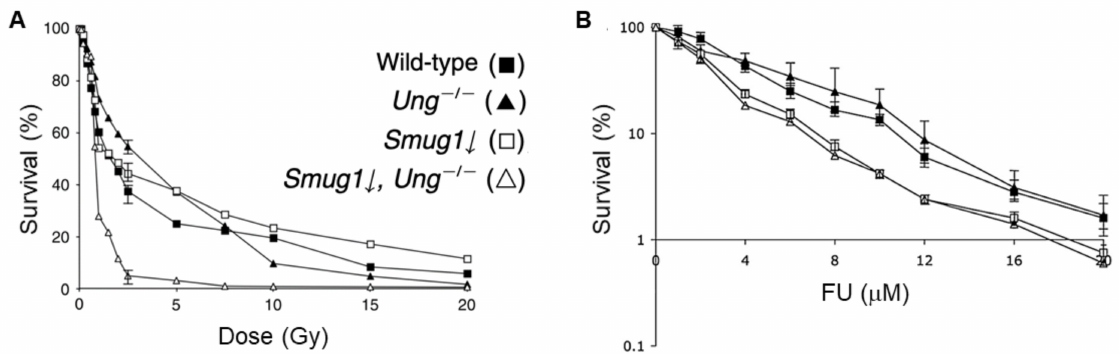
Figure 4. SMUG1 has a protective role after specific types of DNA damage. Survival of wildtype, Ung − / − , Smug1 knock- down and Smug1 knockdown and Ung − / − MEFs were analyzed after treatment with: ( A ) ionizing radiation, from [42] with permission, or ( B ) 5-fluorouracil (FU) from [43] with